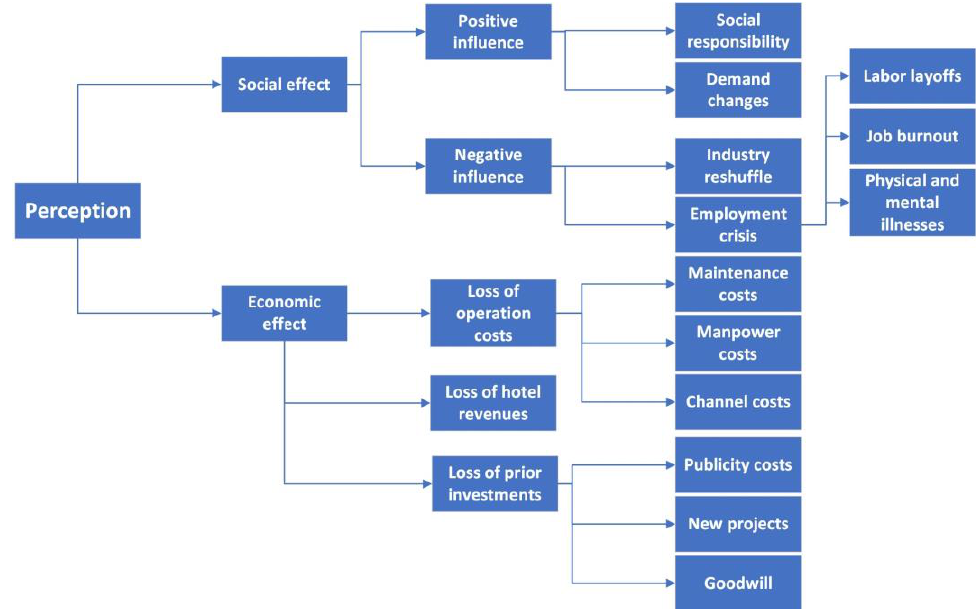
Figure 2. Perception of the influence of COVID-19 on the hospitality and tourism